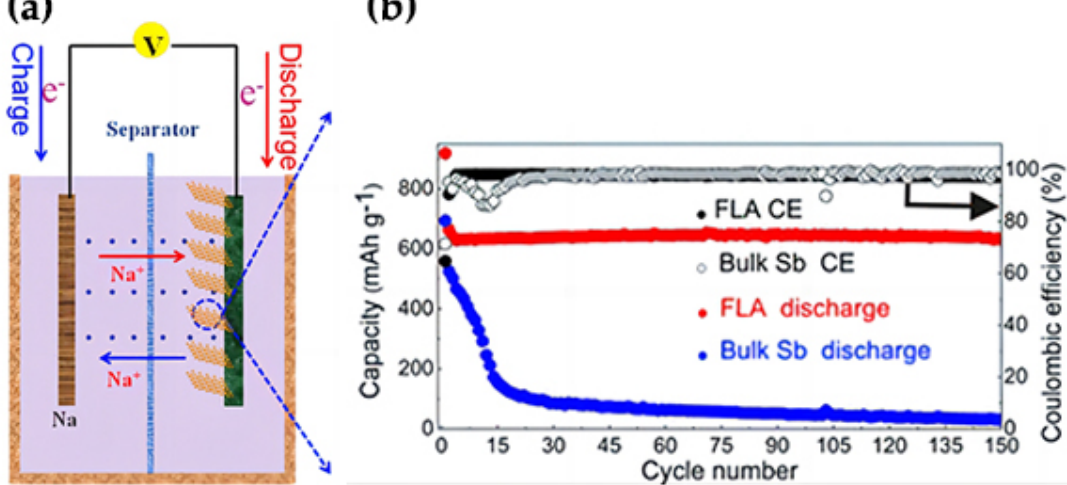
Figure 13. ( a ) Schematic diagram of the Na − ion half − cell composed of few − layer antimonene; ( b ) Long − term cycling performance and Coulombic efficiency of few − layer antimonene and bulk Sb powder at a rate of 0.5 C. Reprinted with permission from Ref. [64]. Copyright 2018, American Chemical Society.